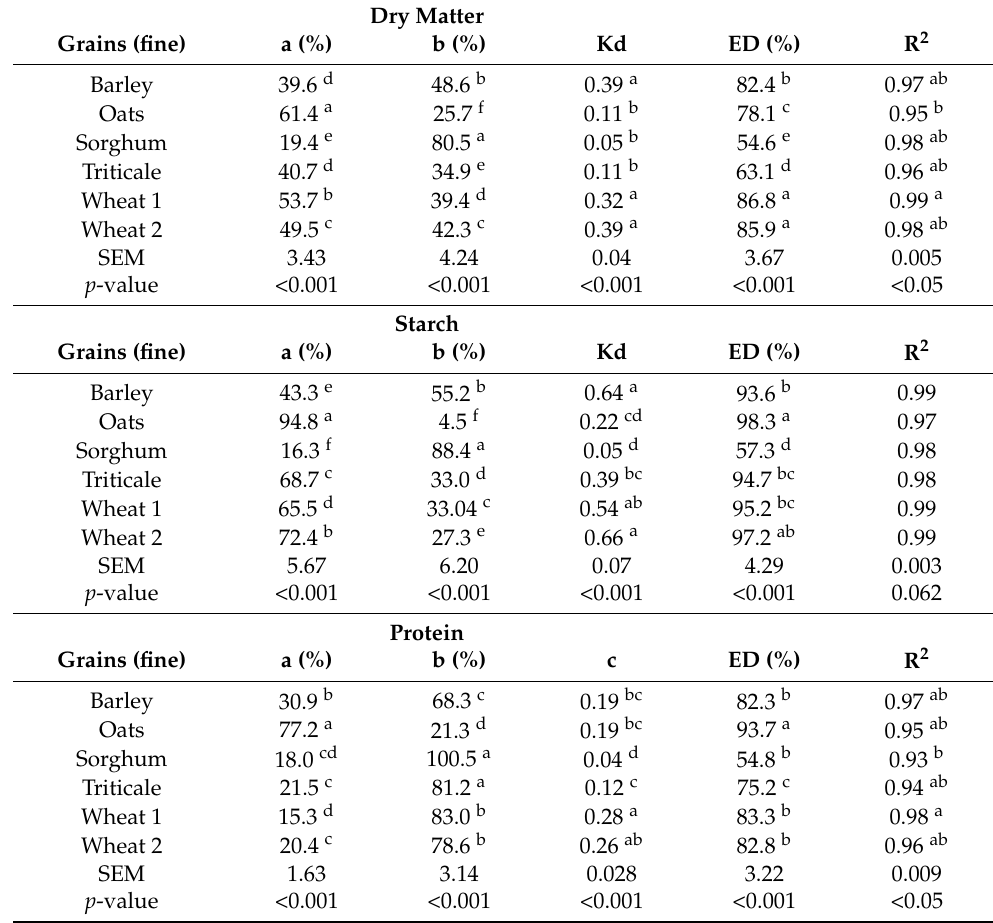
Table 2. The rapidly degradable nutrient (a, %), slow-degradable nutrient (b, %), effective degradation rate (Kd), and the effective degradability (ED, %) of different cereal